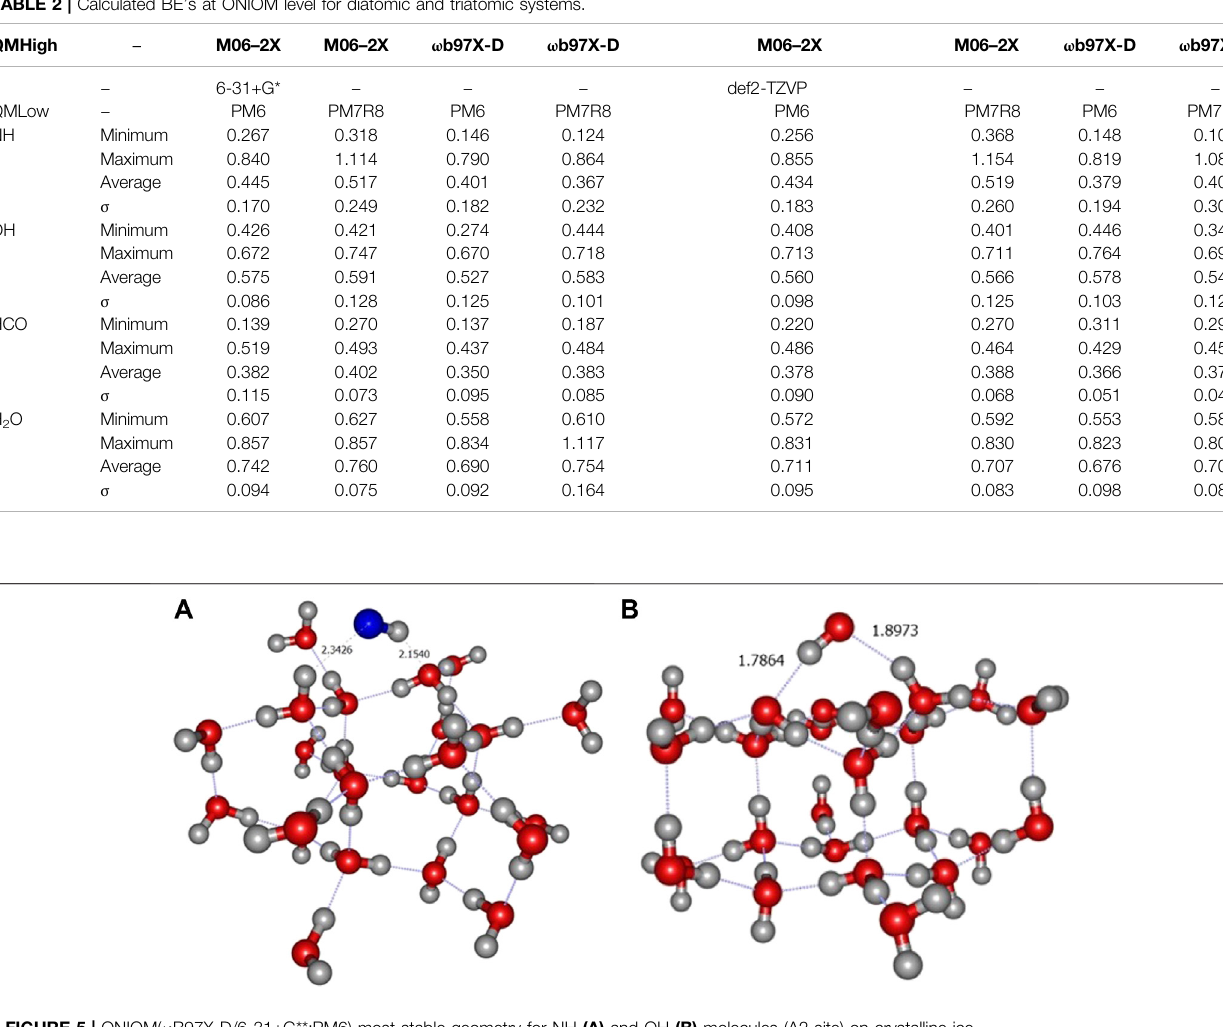
Frontiers in Astronomy and Space Sciences |